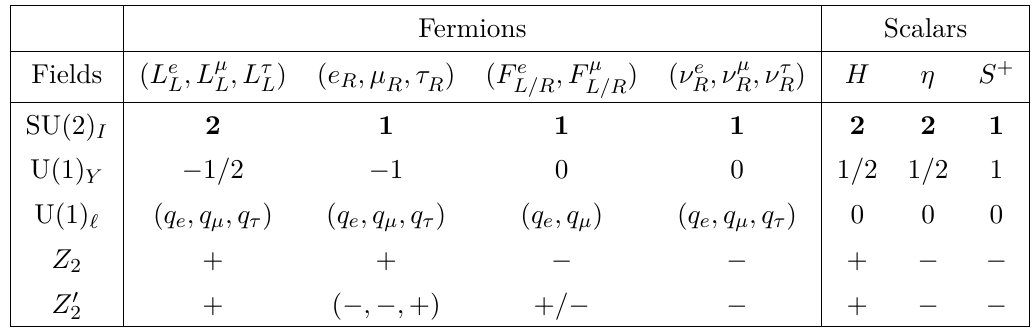
Table 1 . Particle contents and charge assignments under the SU(2) I × U(1) Y × U(1) ‘ × Z 2 × Z 0